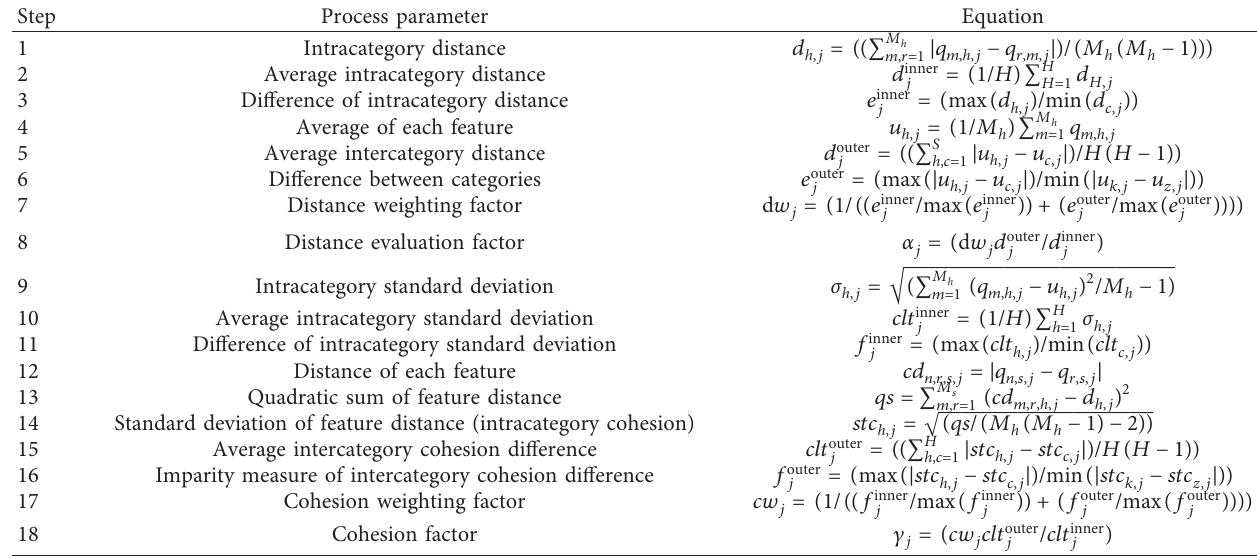
Table 1: Cohesion